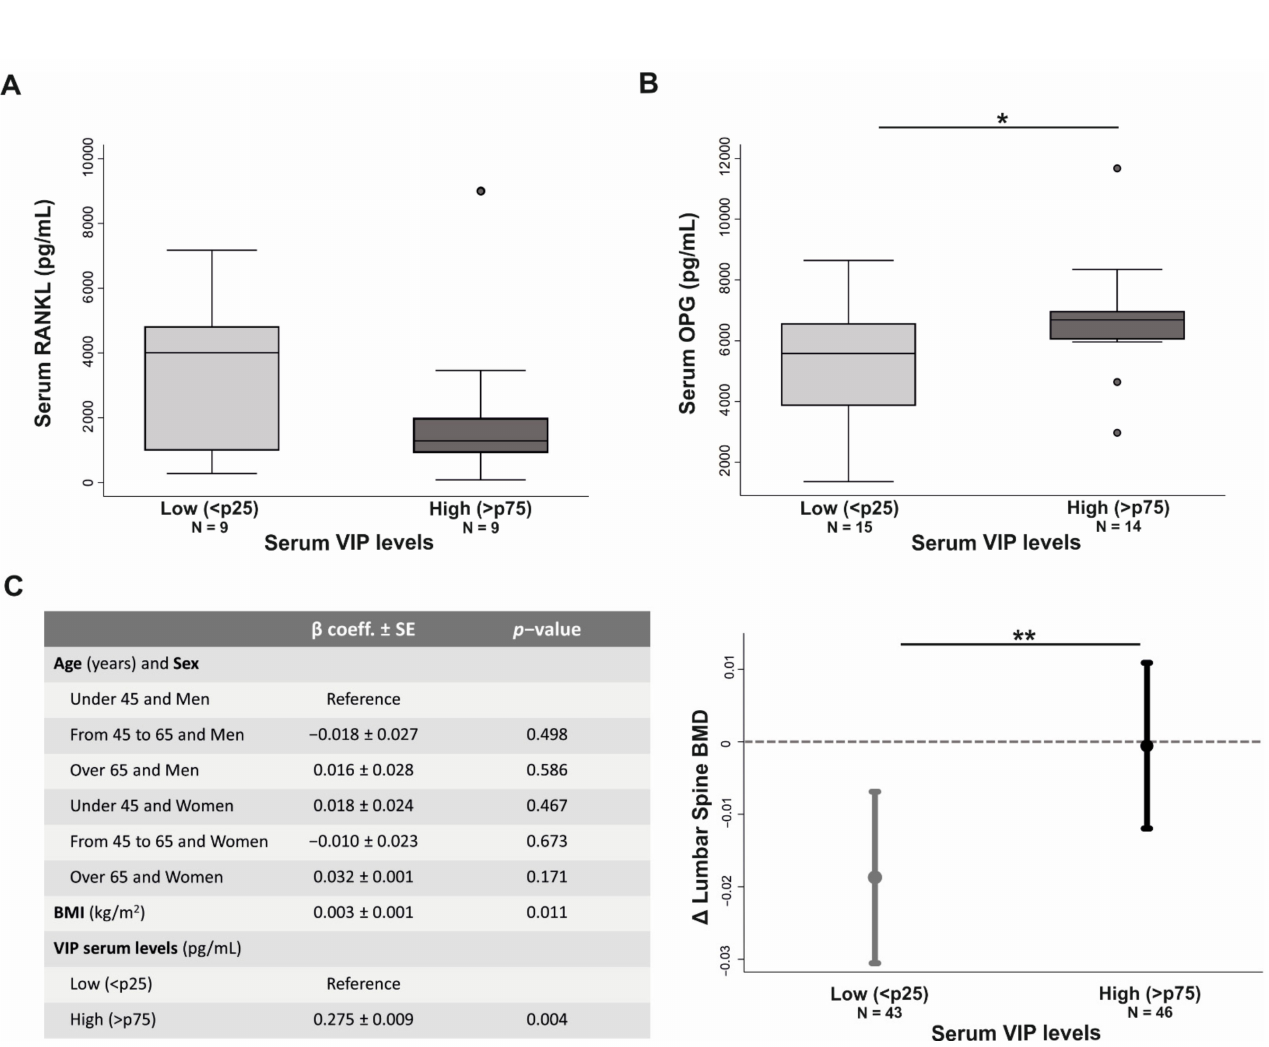
Figure 6. High serum VIP levels reduce bone metabolism markers in patients with early arthritis. Serum concentration of total RANKL ( A ) and OPG ( B ) in early arthritis patients with low (<p25) and high serum (>p75) VIP levels. Data are represented as the interquartile range (p75 upper edge of the box, p25 lower edge, p50 midline), as well as the p90 (line above the box), p10 (line below the box) and dots represents outliers. Mann–Whitney U test was performed. ( C ) Association between serum VIP levels and bone mineral density (BMD) variation from lumbar spine for two years follow-up in early arthritis patients. Data are shown as the mean value of BMD variation for early arthritis patients with low and high serum VIP levels adjusted for the other variables included in the multivariate analysis and the 95% confidence interval. Dotted line indicates no change in lumbar spine BMD (* p < 0.05; ** p <